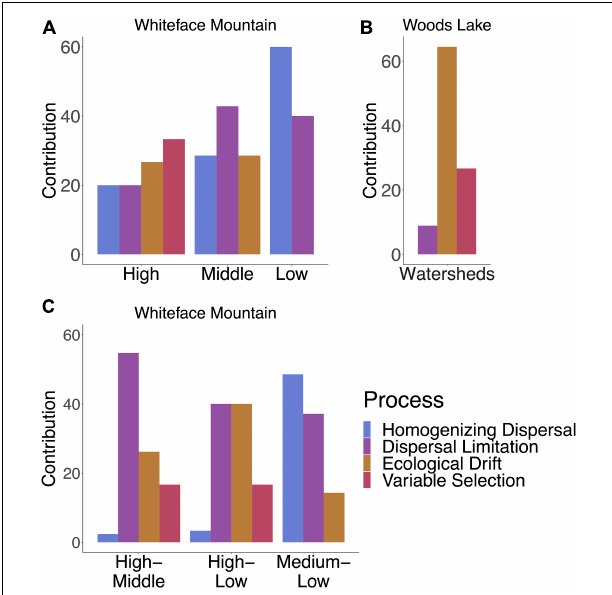
FIGURE 4 | Relative contributions of selection, dispersal, and ecological drift to community assembly vary between sites and within elevation zones in Whiteface Mountain. For WM, High indicates elevations above 1,000 m, Low indicates elevations below 500 m, and Middle indicates 500–1,000 m. (A) Variable selection drives beta diversity at sites above 1,000 m in WM while lower elevations have higher levels of homogenizing dispersal resulting in reduced beta diversity. (B) Dispersal limitation is highest between sites above 1,000 m and the rest of the mountain, while dispersal plays an important role in homogenizing Streptomyces communities between lower elevations. (C) Community assembly at WL is dominated by ecological drift with some variable selection.